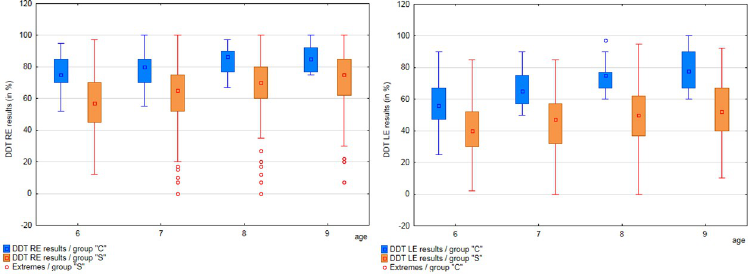
Fig 1. Comparison of DDT RE and LE test results, among age groups, in groups”C” and”S”.